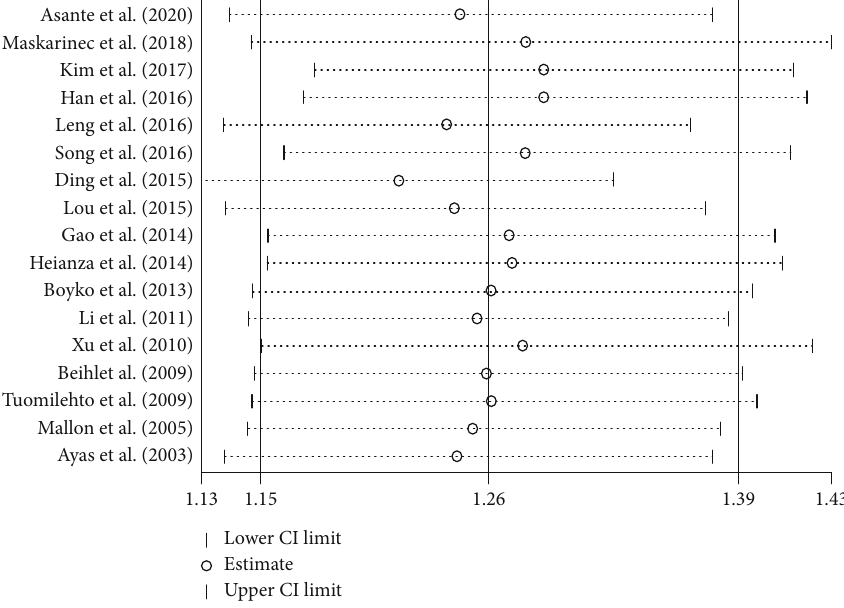
Figure 10: Sensitivity analyses of the association between LSD and T2DM.